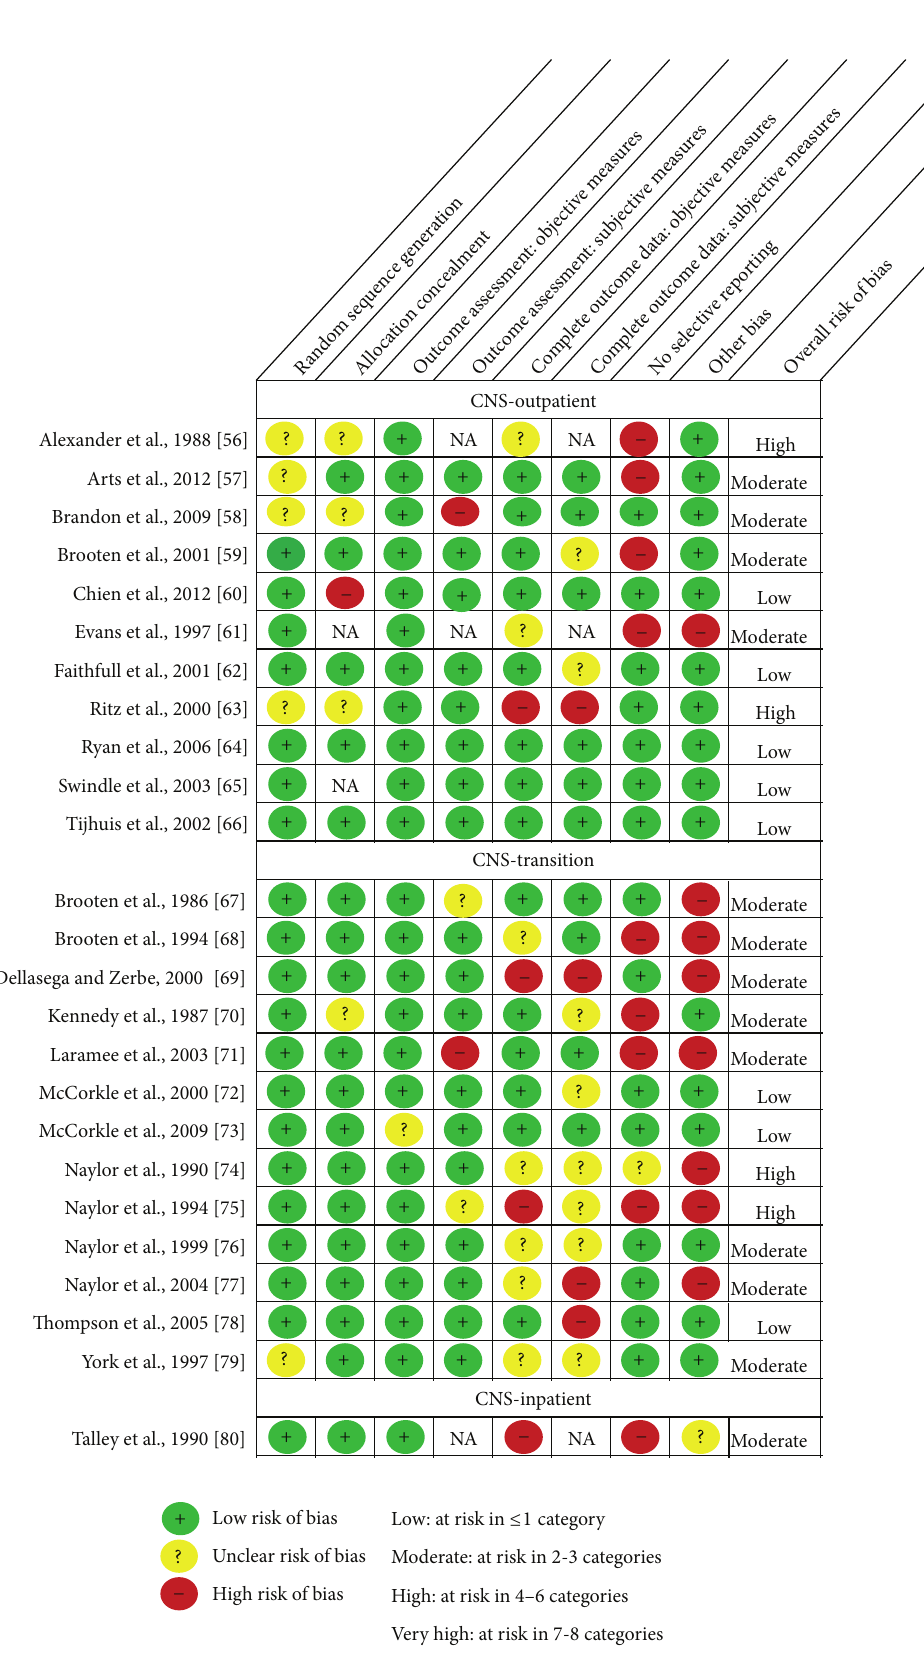
Figure 3: Risk of bias assessment of CNS studies ( 𝑛 = 25